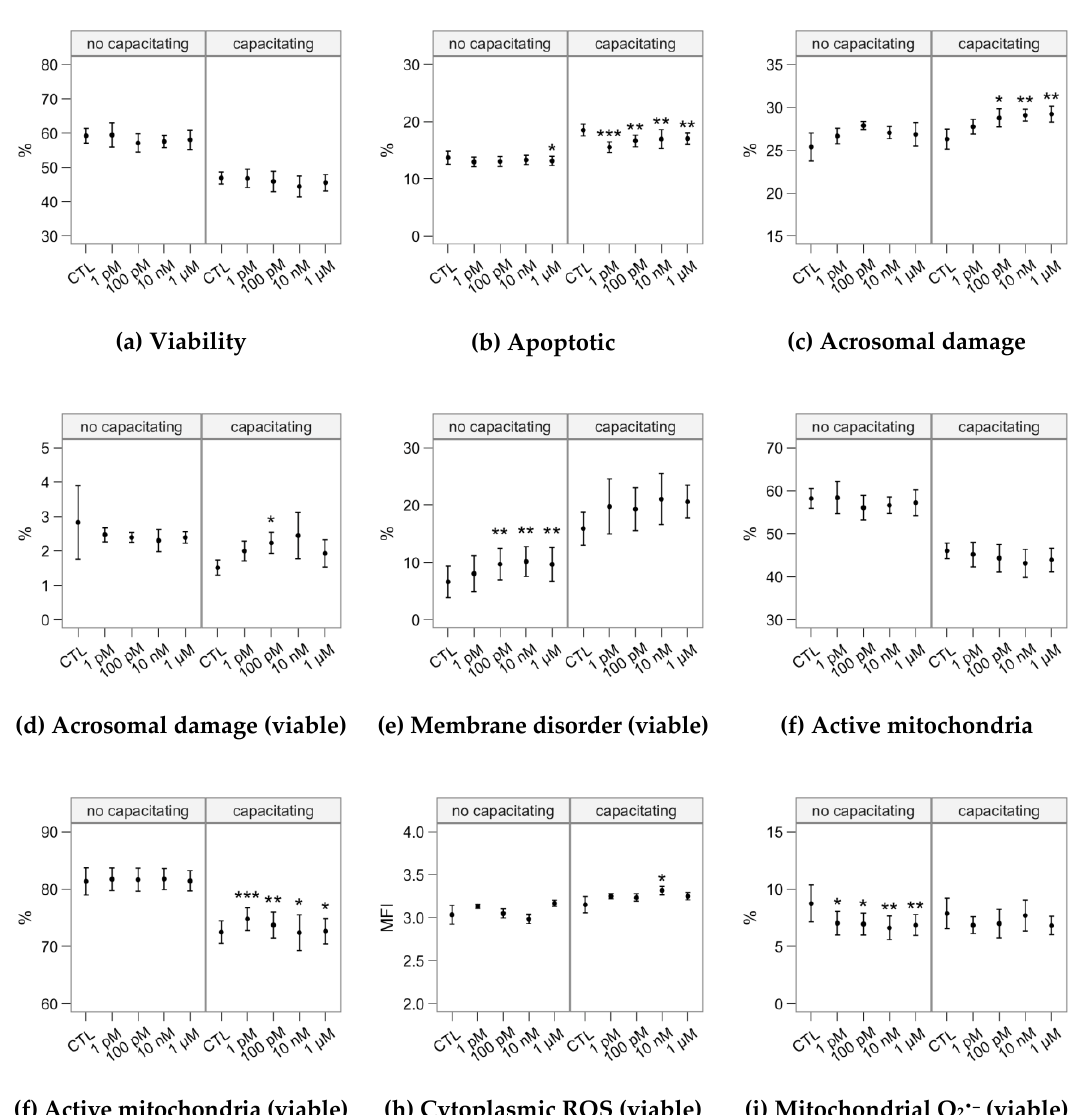
Figure 6. Effects of incubating bull spermatozoa with different melatonin concentrations on some physiological parameters (flow cytometry analysis; Control, no melatonin, as reference). Plots show mean ± SEM for each concentration in the two in the absence (no capacitating) or presence (capacitating) of heparin (variable names expanded in Figure 2). Asterisks label melatonin effects significantly different from the Control (* p < 0.05, ** p < 0.01, *** p < 0.001).